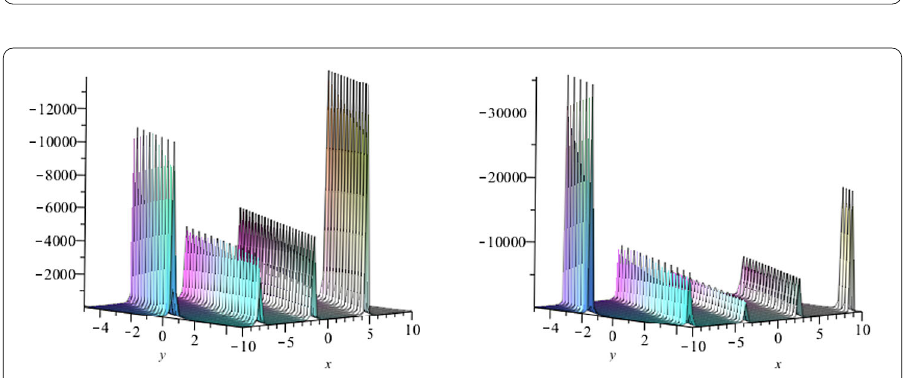
Figure 5 Periodic wave solution of Eq. (4.32) with β = 0.25 and β = 0.9, respectively, when λ = 1